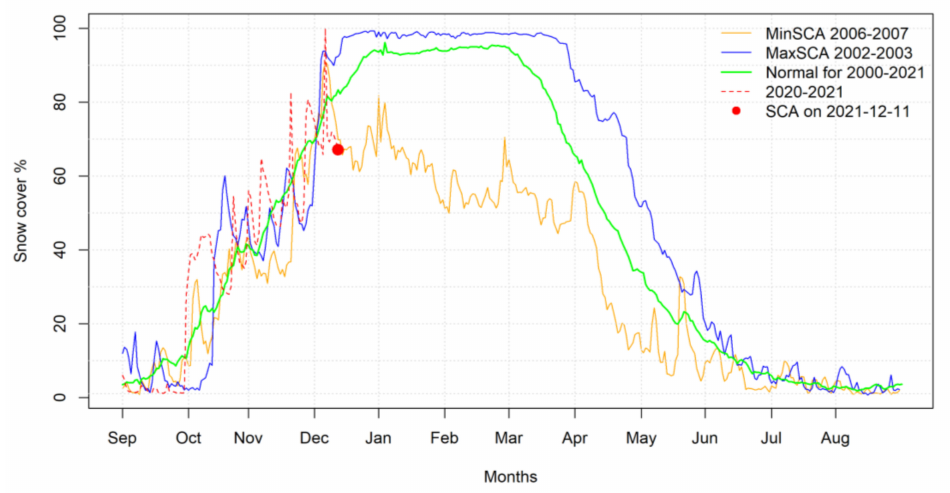
Figure 5. Comparative evolution of snow coverage in the Naryn river basin from 2000 to